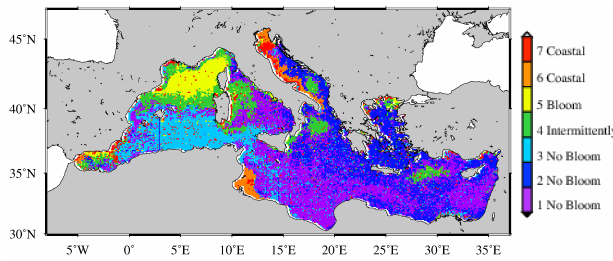
Fig. 6. Spatial distribution of the seven bioprovinces derived from the analysis of the SeaWiFS chl a dataset (D’Ortenzio and Ribera d’Alcala’, 2009).